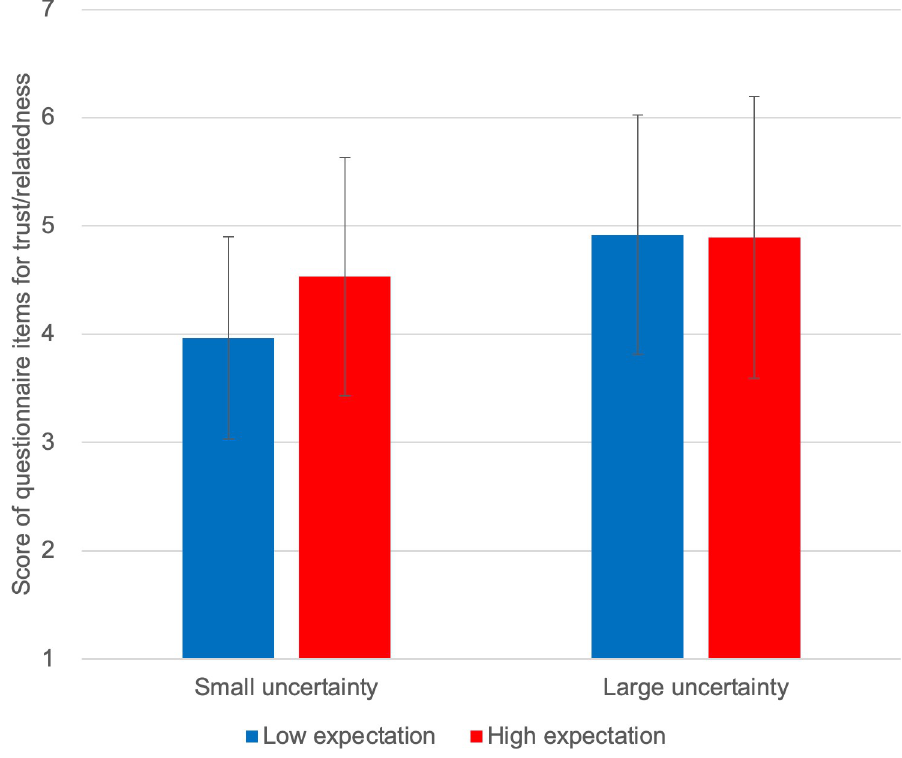
Fig 9. Self-reported